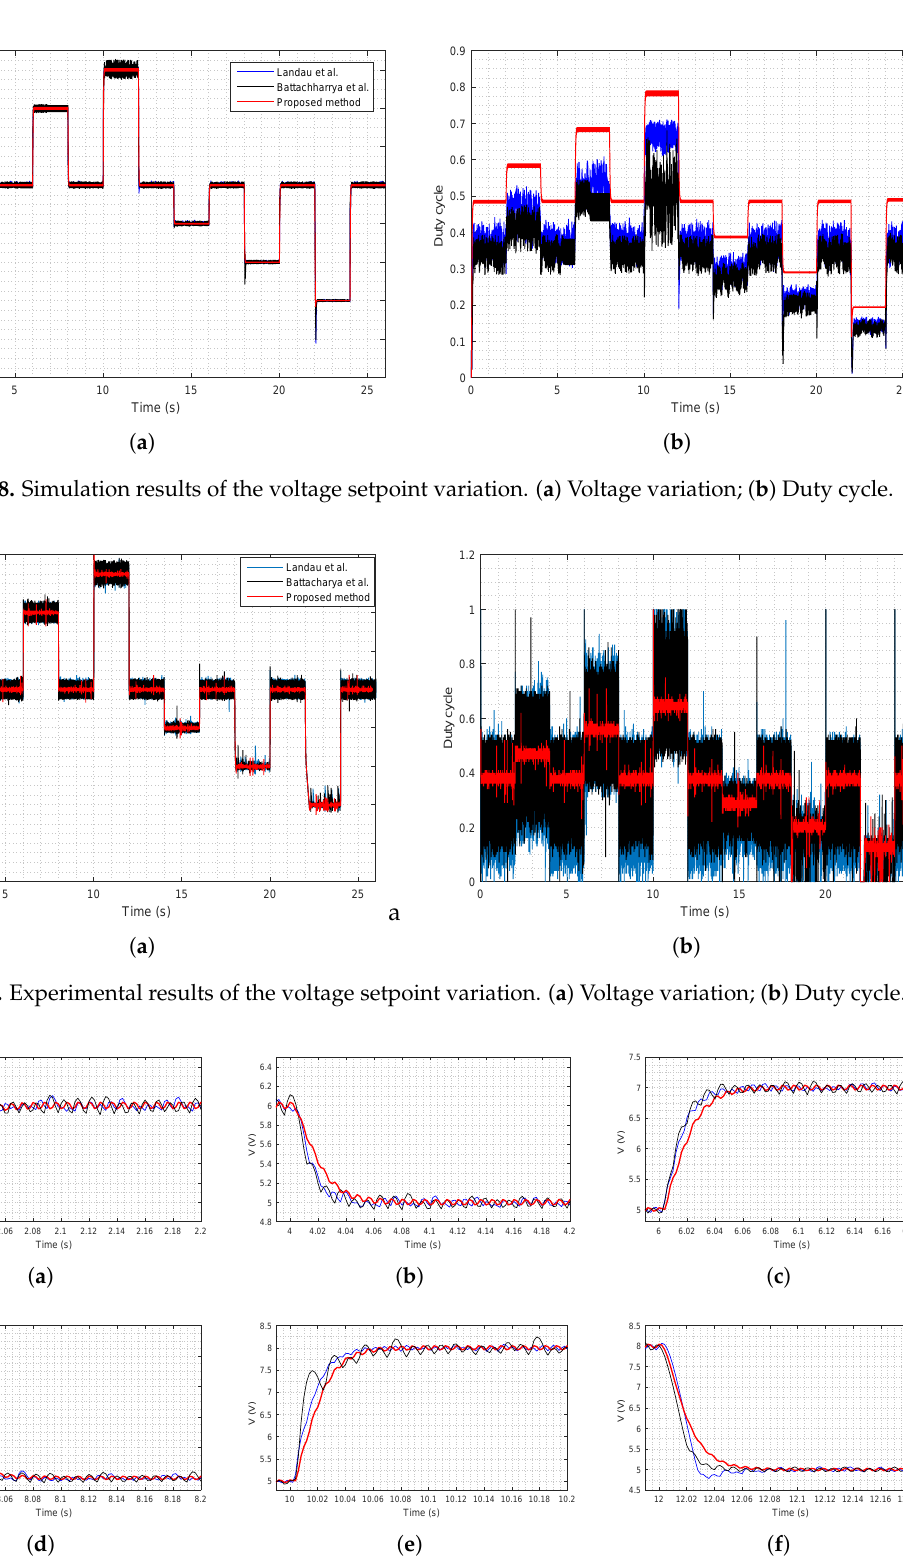
Figure 10. Simulation results of the positive voltage setpoint variation. ( a ) V ref = 6.0 V; ( b ) V ref = 5.0 V; ( c ) V ref = 7.0 V; ( d ) V ref = 5.0 V; ( e ) V ref = 8.0 V; ( f ) V ref = 5.0